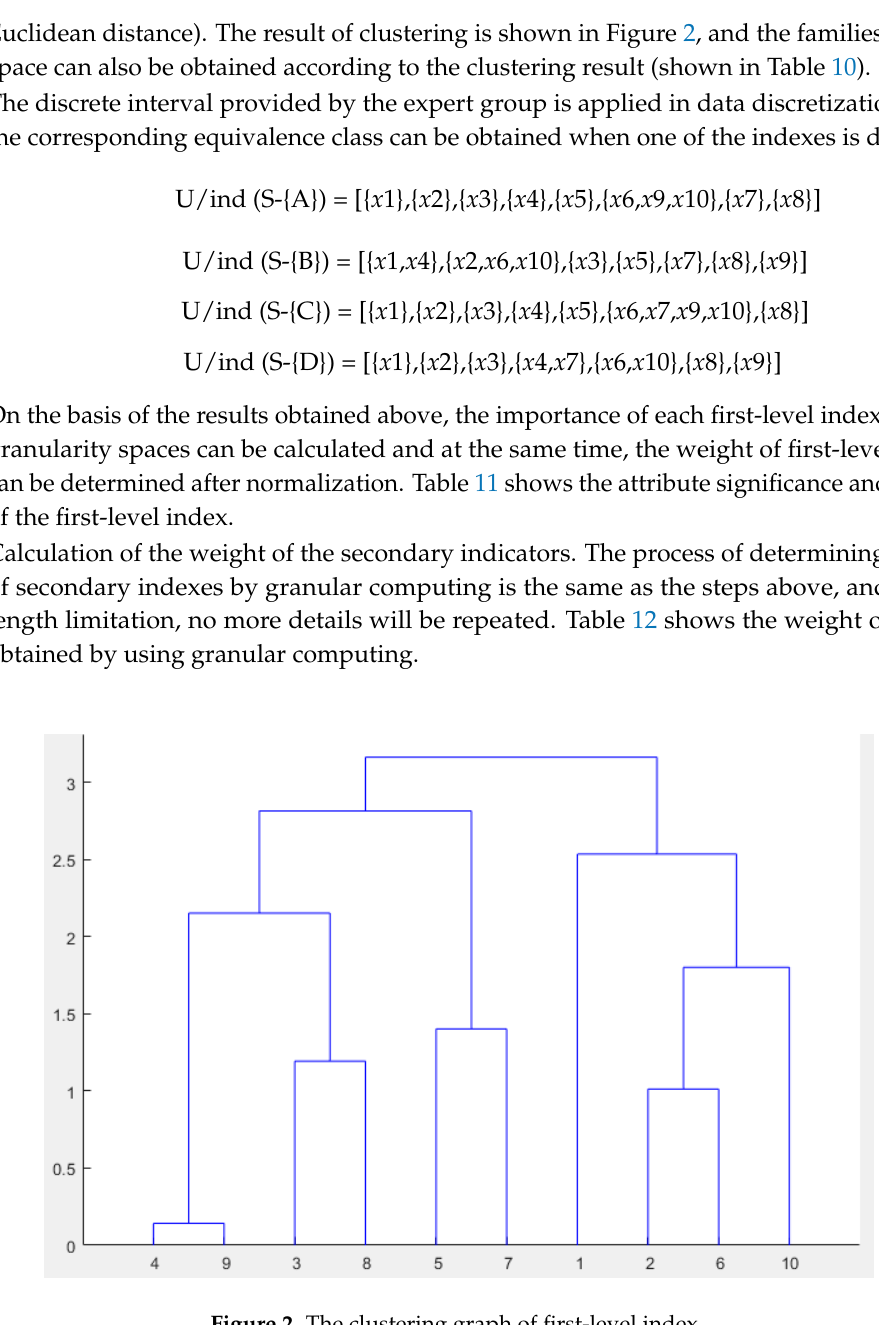
Figure 2. The clustering graph of first-level index. Table 10. Quotient space families.